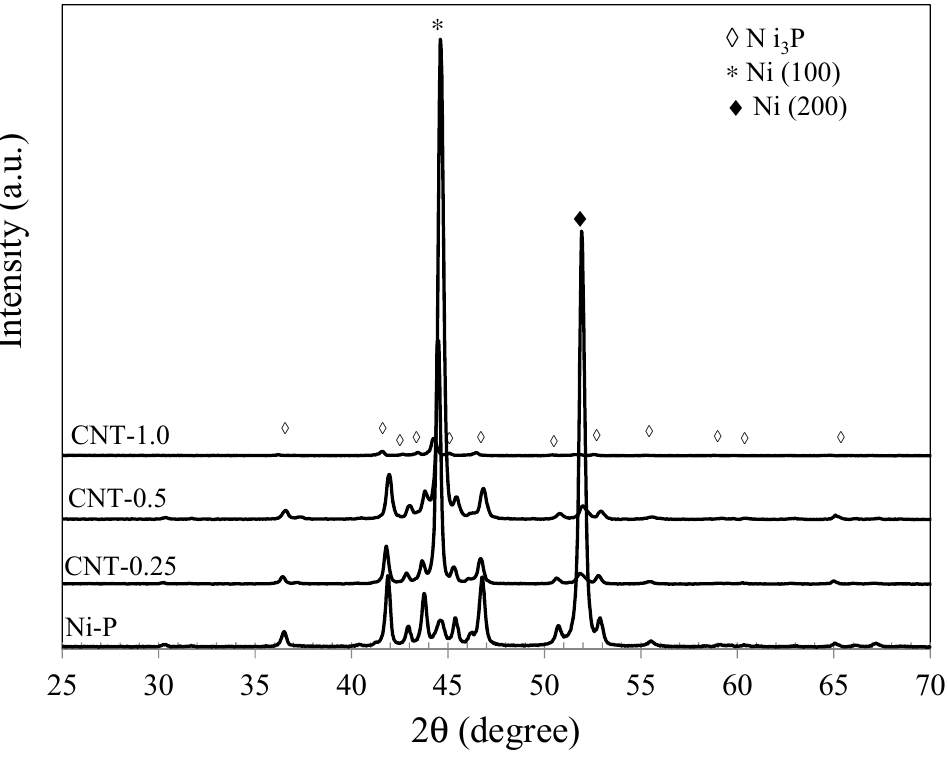
Figure 1. XRD patterns of the Ni–P and Ni–P/MWCNT coatings.